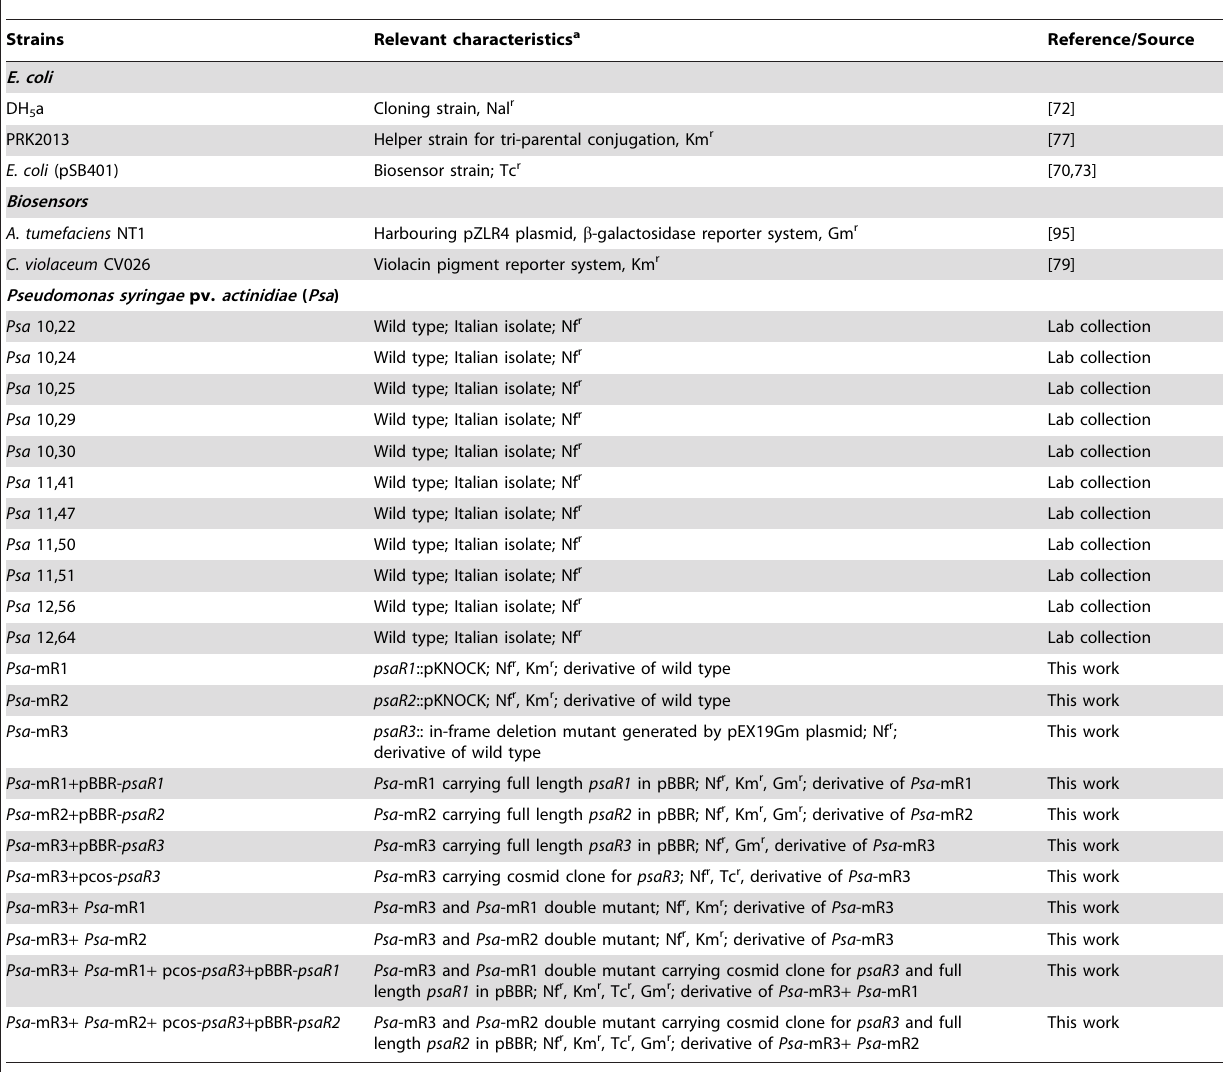
Table 1. Bacterial strains used in this